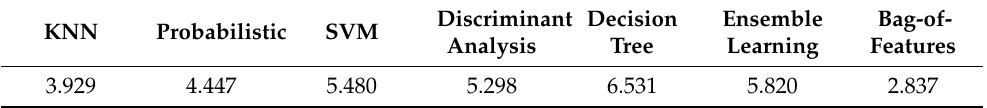
Table 4. Mean absolute error of 50 m by 50 m floor.